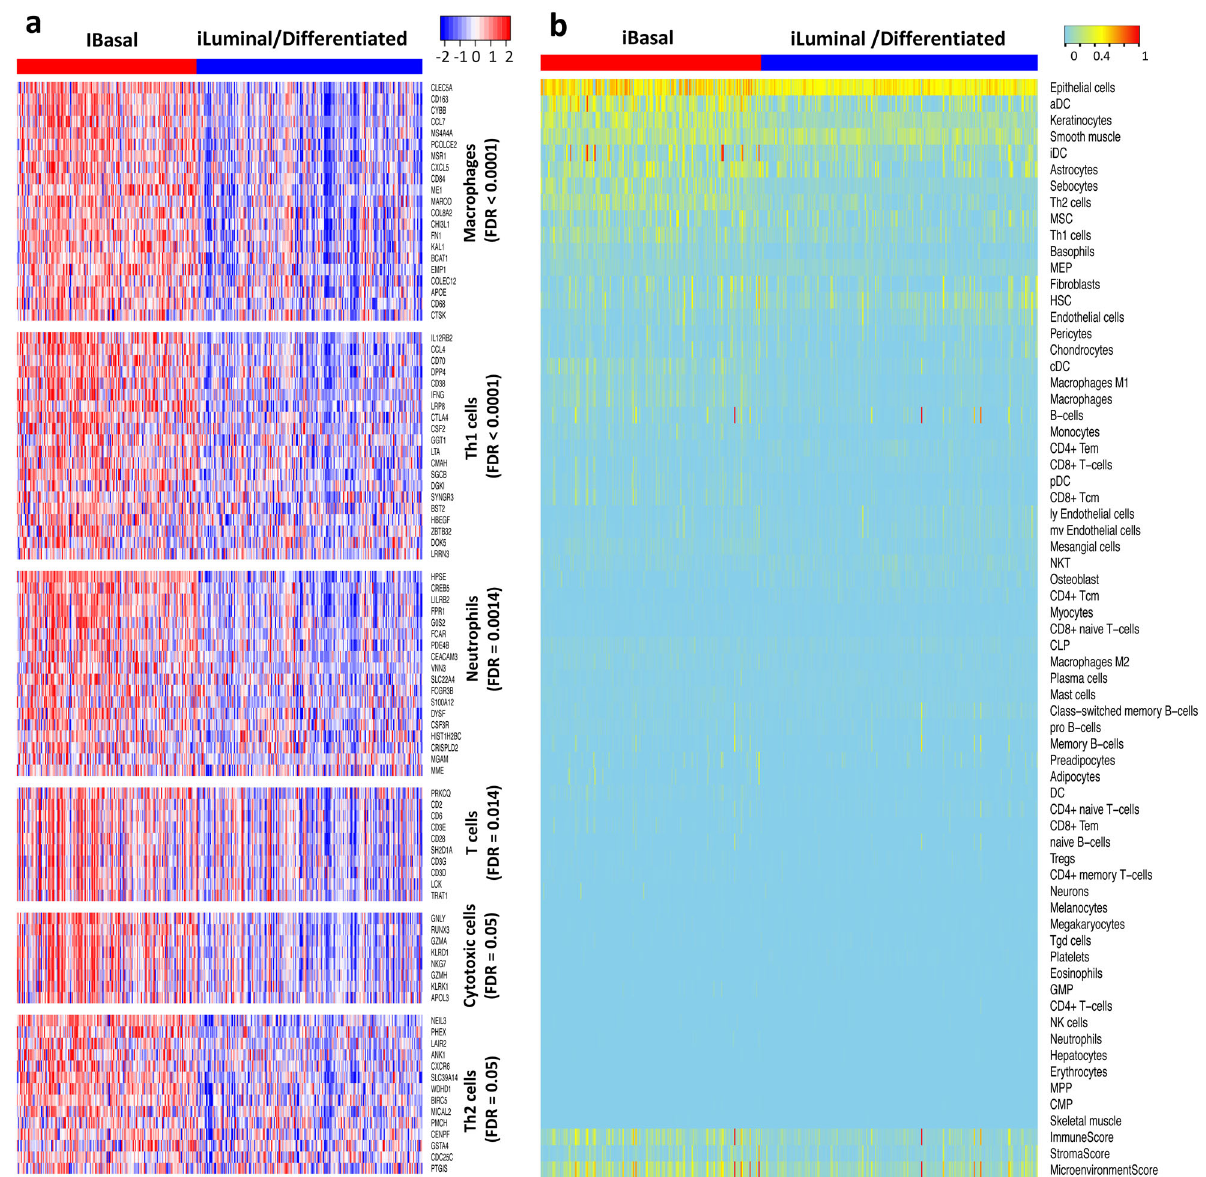
Fig. 7 Digital dissection of TCGA MIBC samples. a Immune-cell-speci fi c gene expression. On the heatmaps, red: high expression, blue: low expression. b xCell scores of the 64 cell types. On the heatmaps, cyan to red represent low to high xCell scores. Columns represent samples, and rows represent cell types and immune, stroma, and microenvironment scores. Gene-based permutation test was used to calculate the